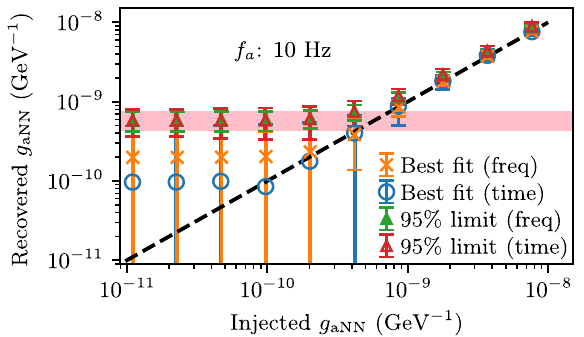
FIG. 11. Signal injection and recovery for an axion mass of 10 Hz. To create these plots, we generate 100 Monte Carlo time- series datasets sampled at 50 Hz and each lasting 40 days long ffiffiffiffiffiffi p with a white-noise background of 900 aT = Hz . The time-binned analysis in Ref. [31] and the frequency-domain analysis in Sec. II are then both used to recover the best fit and 95% upper limit of the coupling constant. Error bars are the standard deviation of the recovered best fit and upper limits values over the 100 simulated datasets, while the markers denote the mean best fit and upper limits over the datasets. The null limit found by running the analysis on 100 null Monte Carlo data sets is shown as a pink